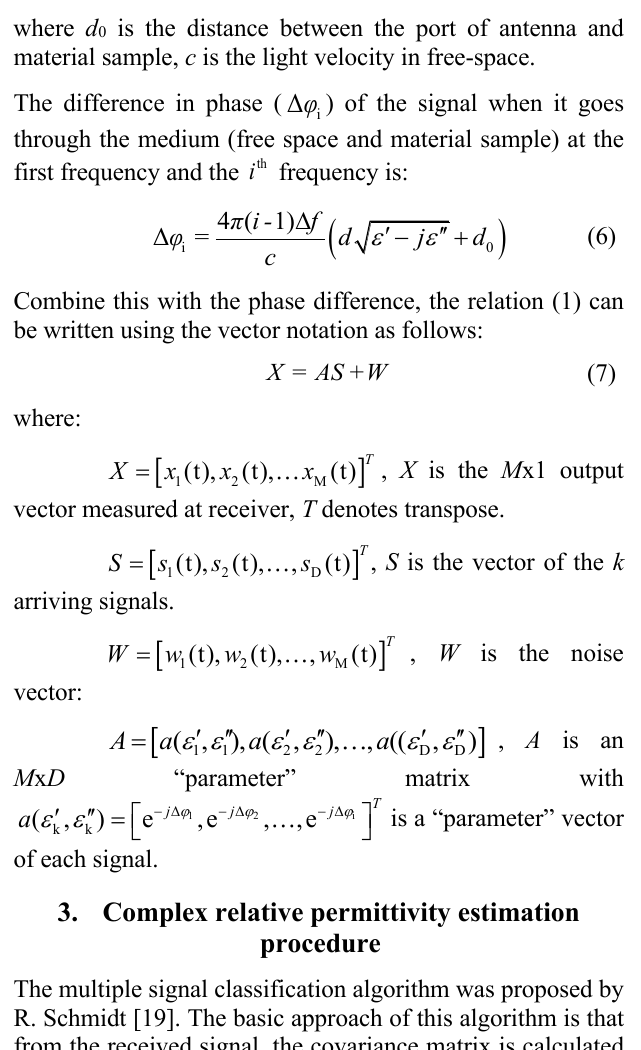
Figure 1: Free-space reflection